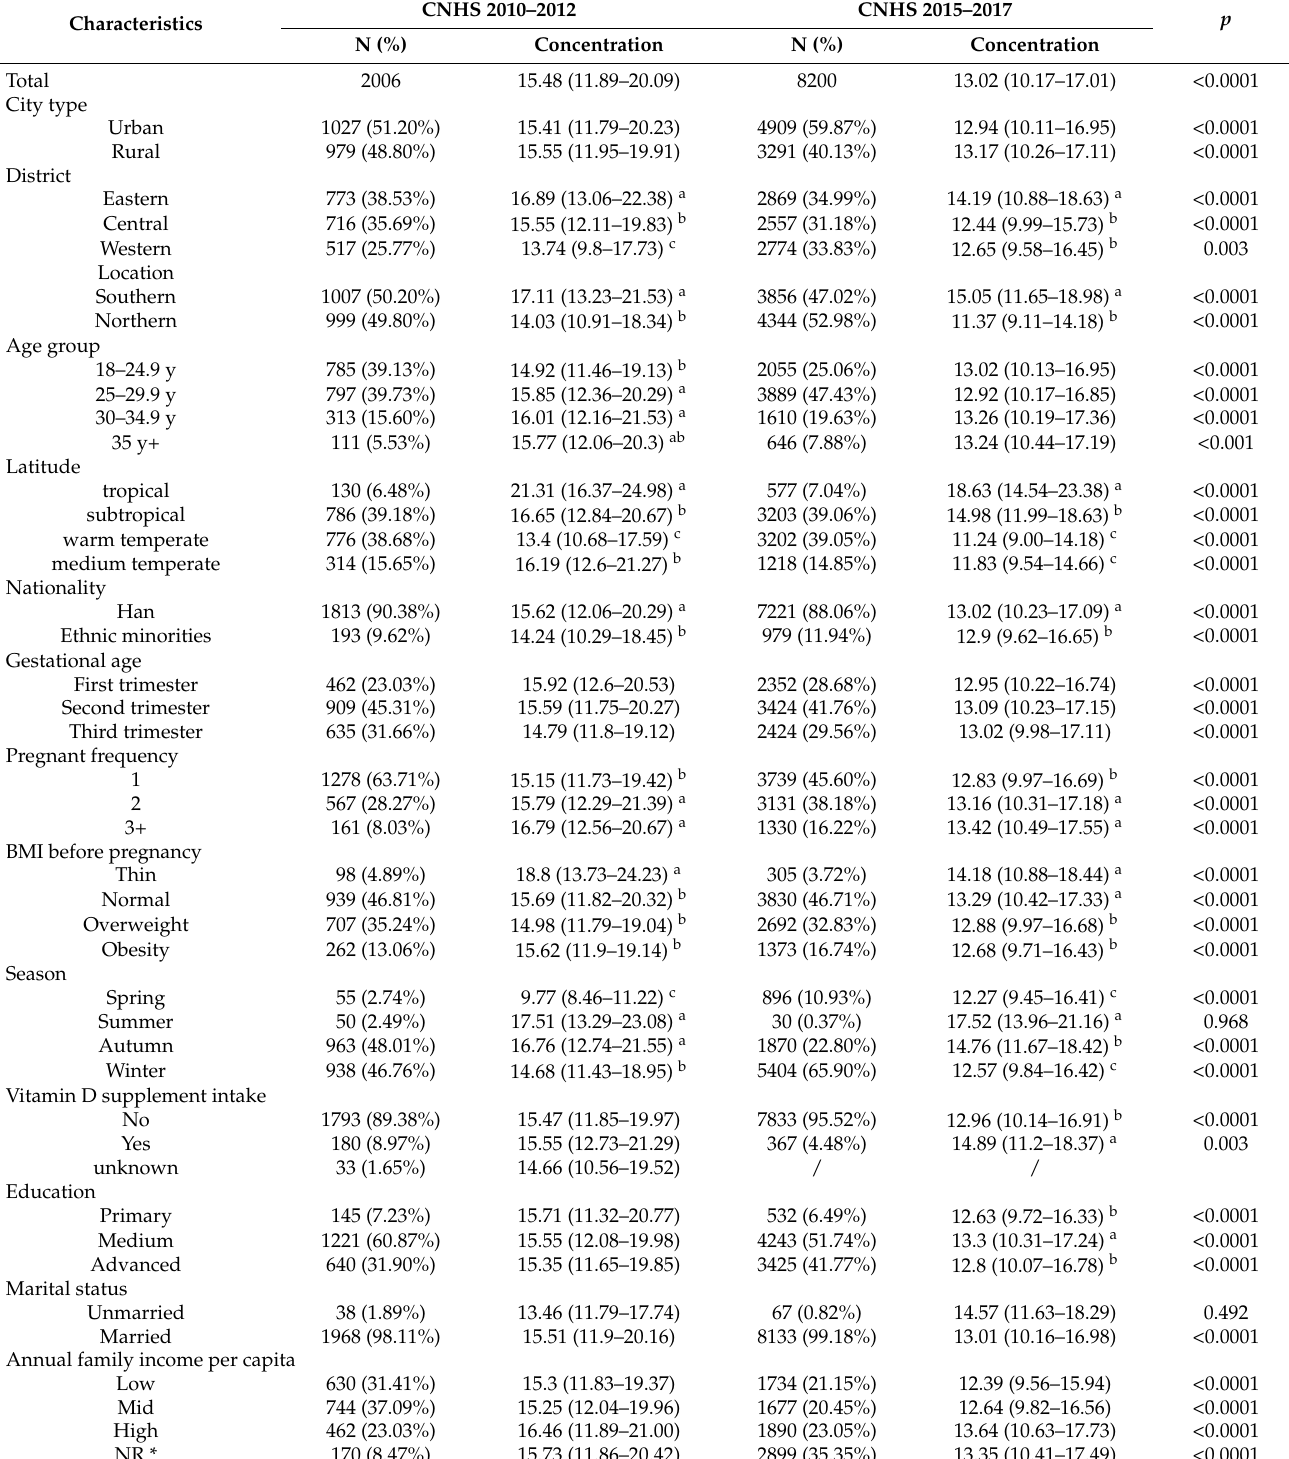
Table 1. Serum 25 hydroxyvitamin D concentration of pregnant women in CNHS 2010–2012 and CNHS 2015–2017 (P50 (P25~P75),